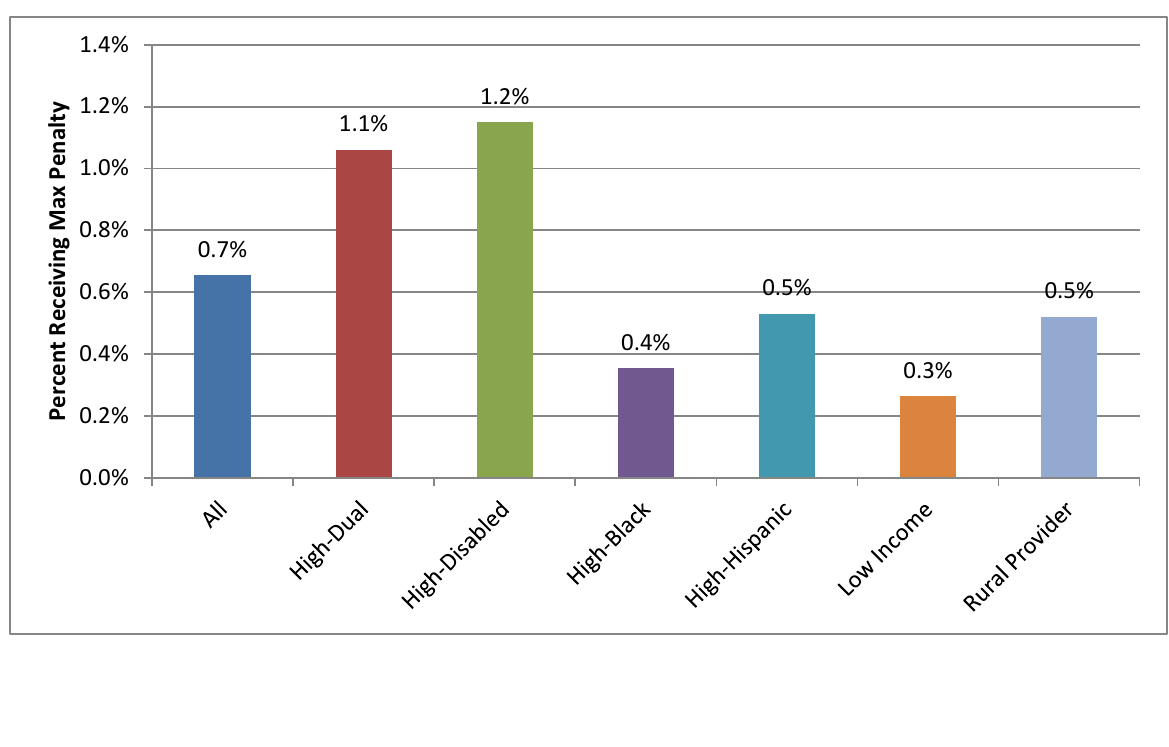
Figure 11.5: Likelihood of Maximum (2%) Penalties by Facility